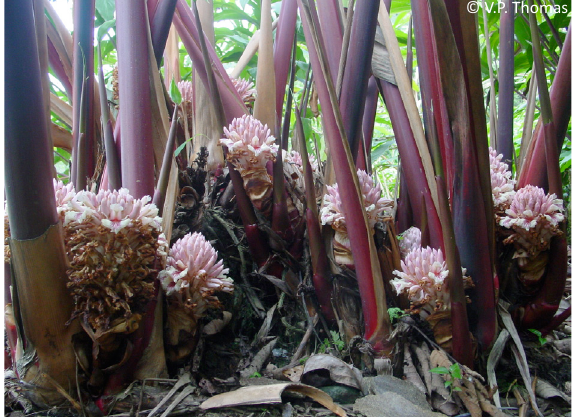
Image 1. Amomum kingii - Inflorescences